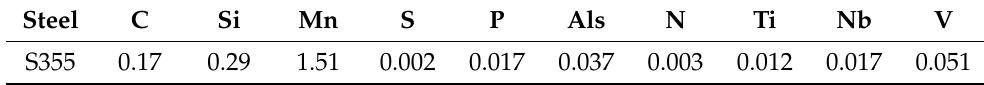
Table 1. Chemical composition of typical steel